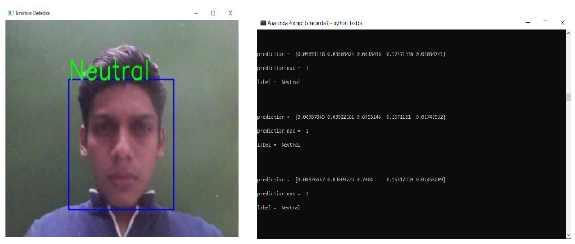
Fig 9. Prediction of Neutral Emotion Table II Comparison with other DL Models